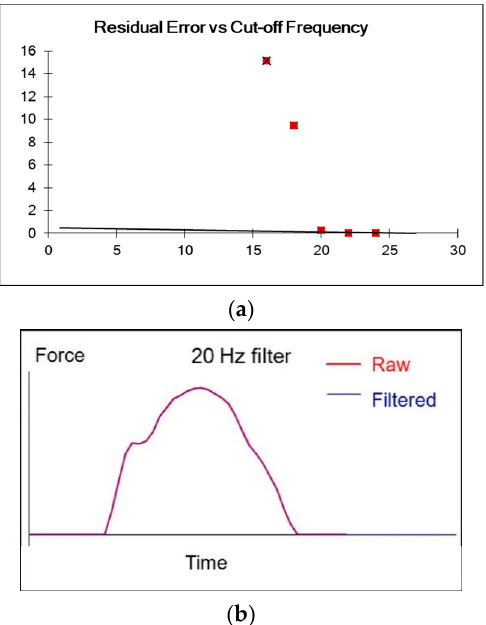
Figure 3. Data processing with a 4th order low-pass Butterworth filter: ( a ). Comparing among cut-off frequencies of 16, 18, 20, 22, and 24 Hz. ( b ). The 20 Hz filter was deemed to be the most